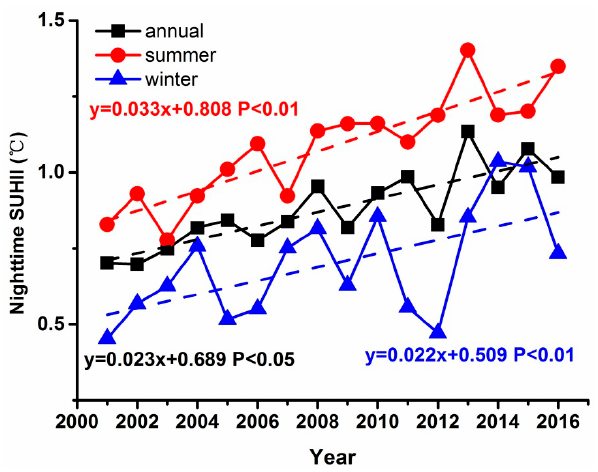
Figure 6. The temporal trends of nighttime SUHII averaged for 10 cities during 2001–2016.